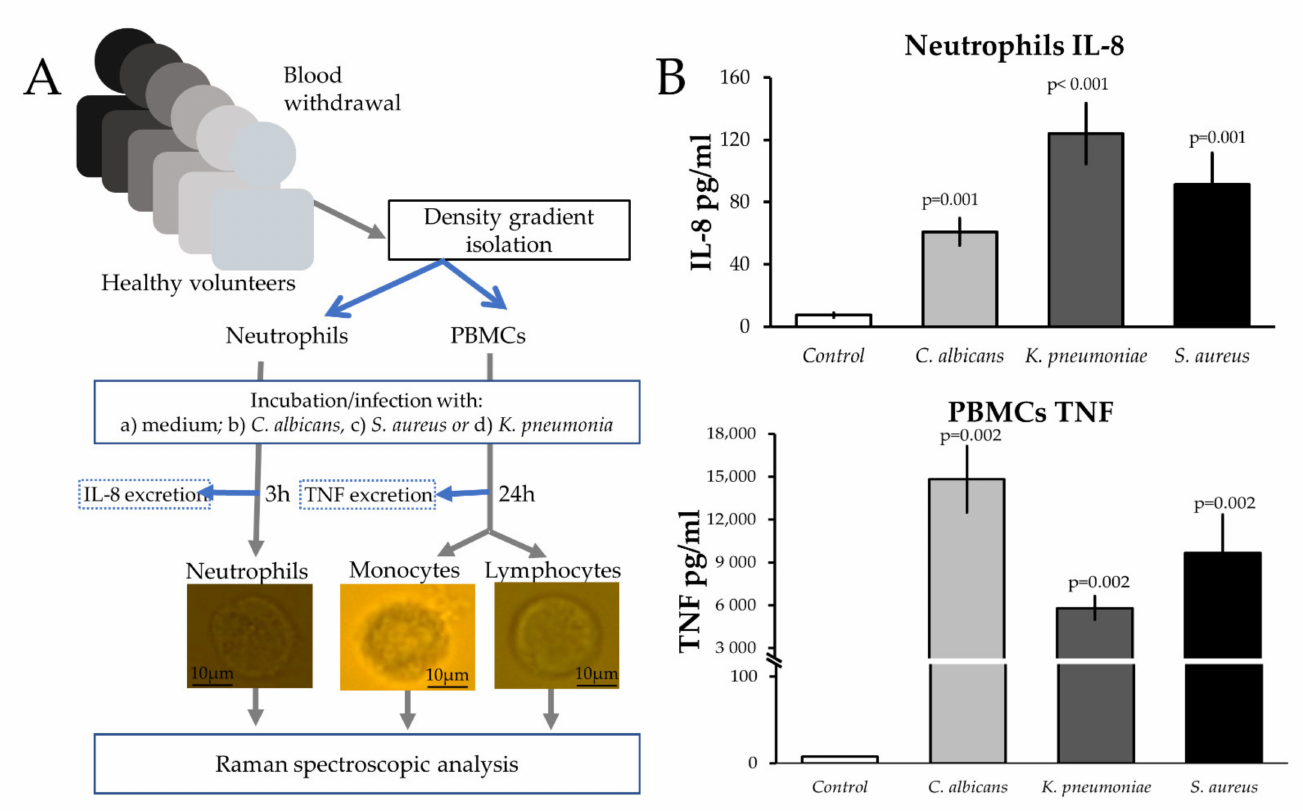
Figure 1. ( A ). Schematic depicts an experimental flow. ( B ). Concentrations of IL-8 in neutrophils and TNF in PBMCs supernatants (mean ± SE). p -values show a statistical difference compared with the control group. There is no error bar for the control treatment of TNF because all measured concentrations were below the limit of